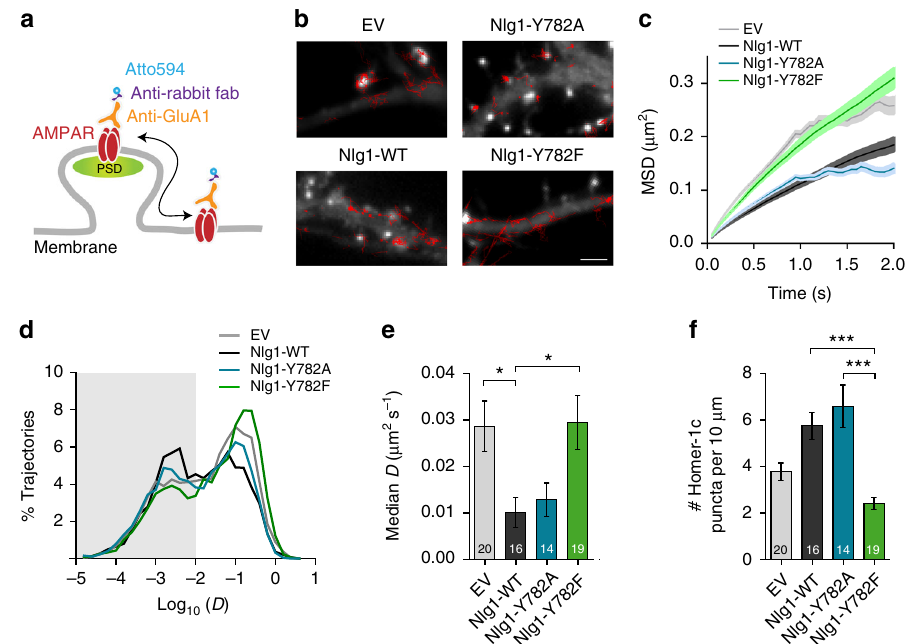
Fig. 3 Nlg1-Y782A but not – Y782F trap surface-diffusing AMPARs. a Neurons were live labeled for endogenous AMPARs with a GluA1 antibody mixed with Atto594-conjugated anti-rabbit Fab. The postsynaptic density (PSD) was detected with Homer1c-GFP. b Representative trajectories of individual AMPARs at the neuronal surface (red) in DIV 10 neurons expressing EV, Nlg1-WT, -Y782A, or -Y782F and Homer1c-GFP (white). Scale bar, 2 µ m. c Average mean square displacement (MSD) and d distributions of individual diffusion coef fi cients in log scale from one experiment, for the four conditions (number of cells/number of trajectories, EV: 8/5690; Nlg1-WT: 7/4340; Nlg1-Y782A: 8/18059; Nlg1-Y782F: 8/16978). Note the higher MSDs and larger peaks of mobile receptors for EV and Nlg1-Y782F, compared to Nlg1-WT and -Y782A. The fraction of slowly mobile molecules on the left of the histogram ( D < 0.01 µ m² s − 1 ) is gray-shaded. e The median diffusion coef fi cient per cell was averaged for each condition (3 independent experiments). The number of cells examined is given in the columns. f Effect of the Nlg1 mutations on the number of Homer-1c puncta per unit length of dendrite (3 independent (* P < 0.05, *** P <